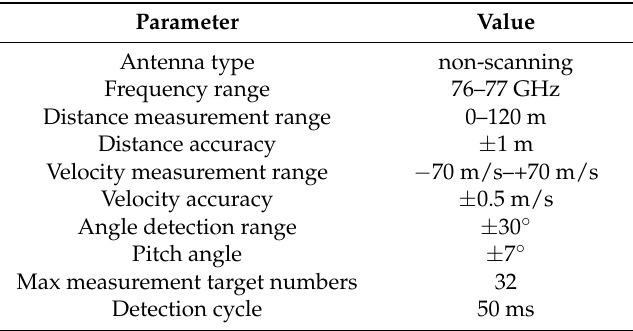
Table 1. Technical parameters of the millimeter ‐ wave radar.